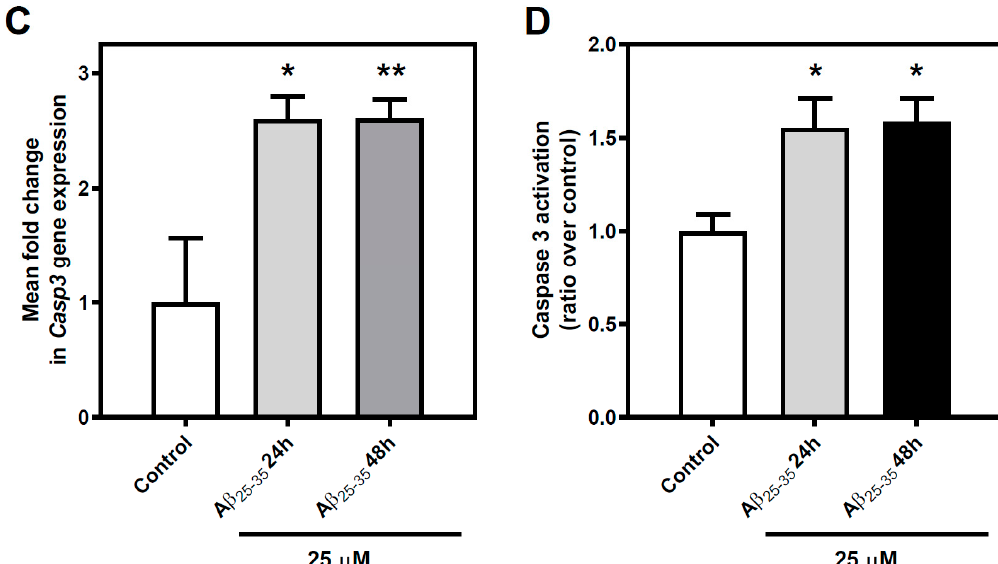
Figure 1. Effect of A β 25-35 and A β 1-42 exposure on cell viability of cortical neurons. ( A ) Cortical neurons were exposed to different concentrations of the soluble form of A β (A β 25–35 ) (1–50 µ M) for 24 h and MTT reduction was used as a measure of cell viability. Only high concentrations of A β 25–35 ( ≥ 25 µ M) significantly reduced cell viability under these conditions. ( B ) Cortical neurons were subjected to 25 µ M A β 25–35 for 24 and 48 h or to 25 µ M A β 1–42 for 24 h and cell viability was determined as described in Methods. No differences were reported when the exposition time was prolonged using A β 25-35 or when A β 1–42 was used instead A β 25-35 in the same conditions. ( C ) Expression levels of Caspase 3 ( Casp3 ) were determined under experimental conditions. Gene expression was incremented when cortical neurons were exposed to A β 25–35 . ( D ) Caspase 3 activity was increased by A β 25-35 exposure. Mean ± SEM values obtained are represented; each point was measured in triplicate employing, at least four different cultures. * p < 0.05, ** p < 0.01 significantly different from control value using one-way ANOVA and Bonferroni’s post hoc test.